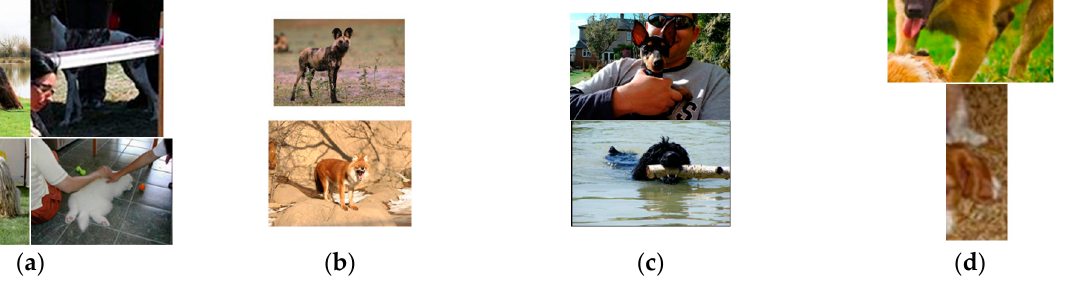
Figure 14. Reasons for detection errors in TestSet2 data-set experiment. ( a ) Obscured facial features; ( b ) Special breed of dog; ( c ) Obscured or cropped body; ( d ) Incomplete dog region.